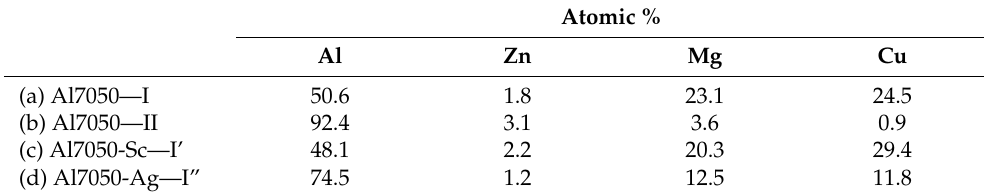
Figure 3. Typical BSE images of ( a ) Al7050, ( b ) Al7050-Sc, and ( c ) Al7050-Ag. Table 2. Chemical investigations of intermetallic particles, as shown in Figure 3.